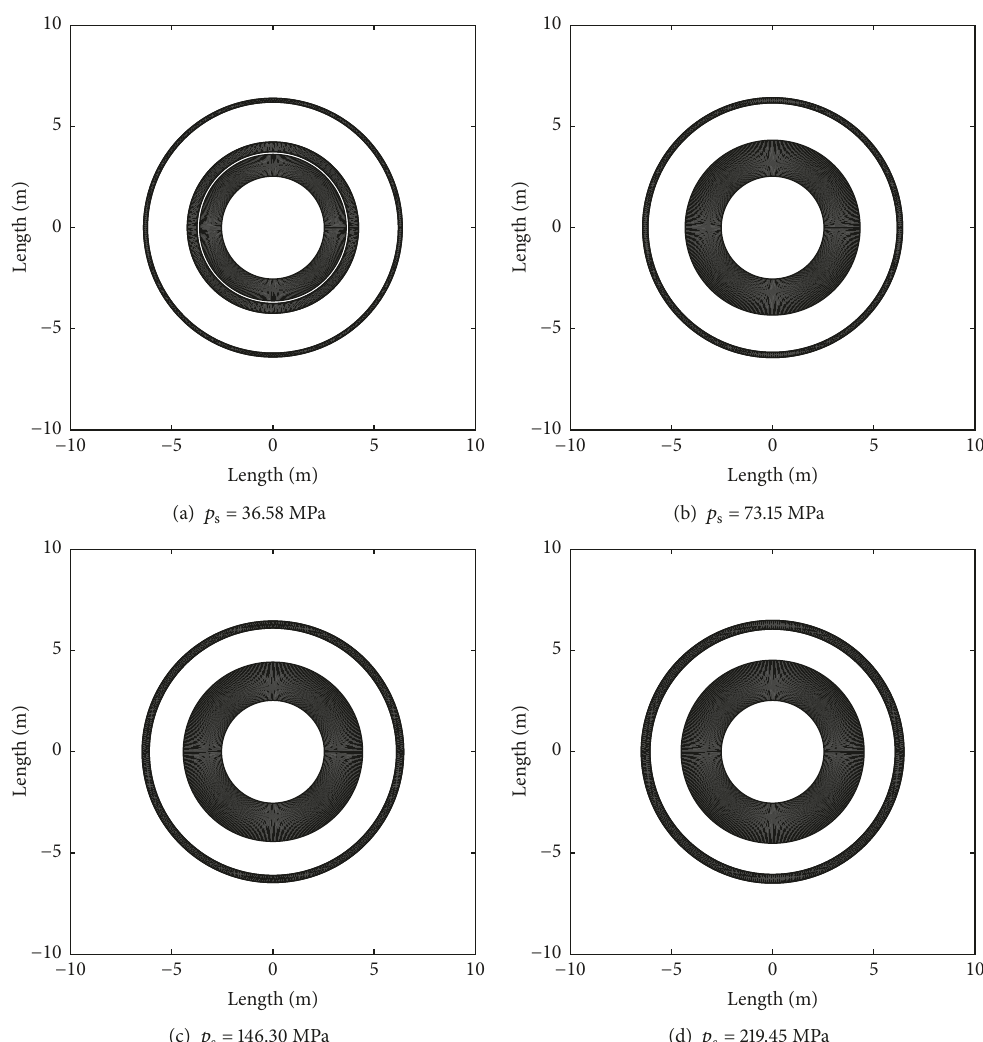
Figure 8: Effect of peak radial blasting load 𝑝 s on zonal